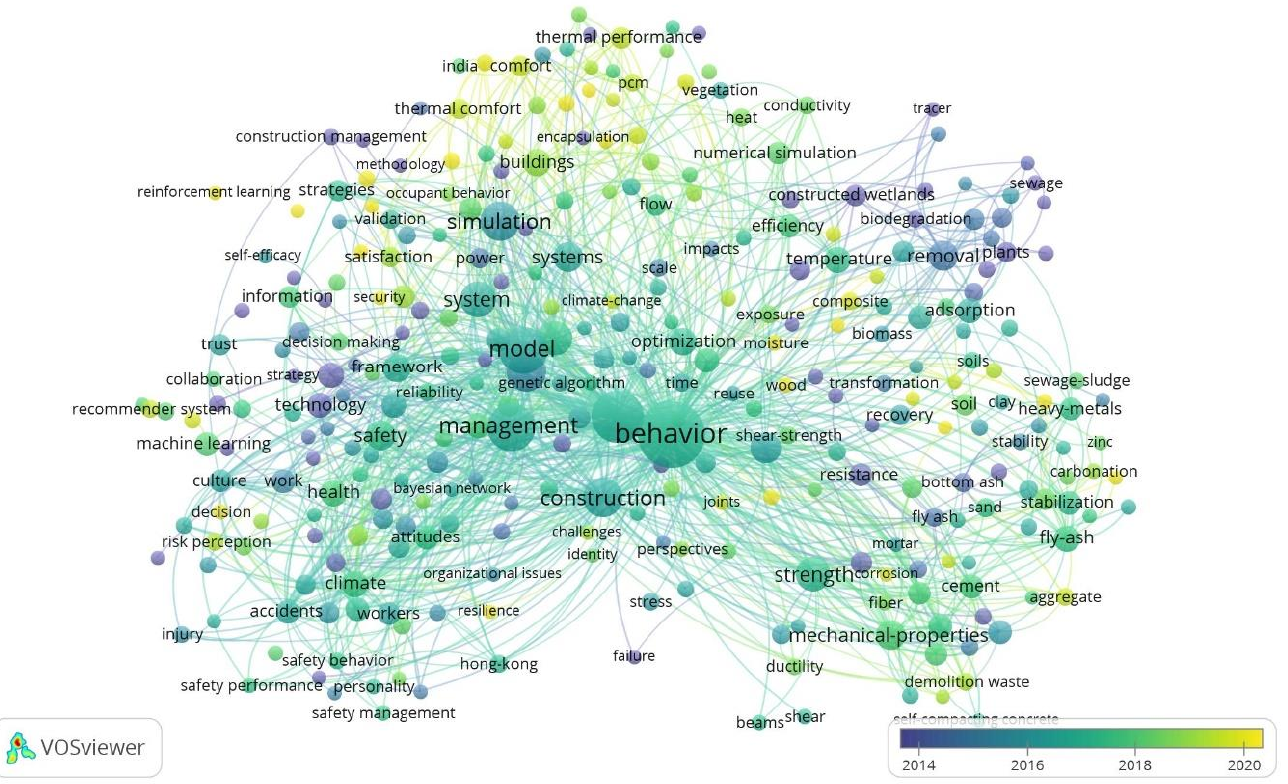
Figure 5. Keywords and timing progress. Table 3. Keywords and timing progress examples.